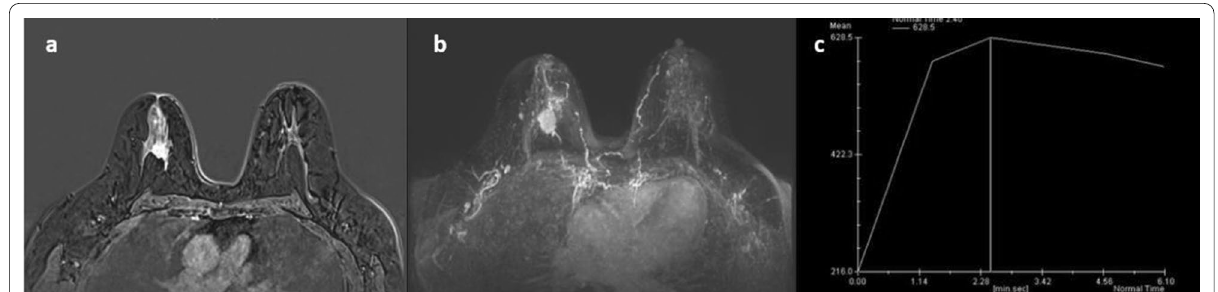
0.01. a T1 fat‑suppression = 19 21 mm, associated with × ×